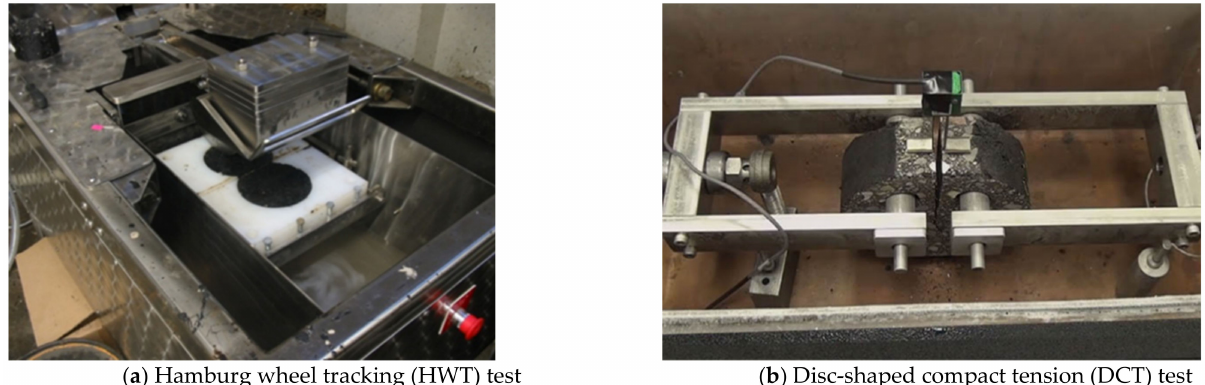
Figure 5. Pictures of HWT and DCT testing equipment to determine moisture susceptibility and low-temperature crack- ing